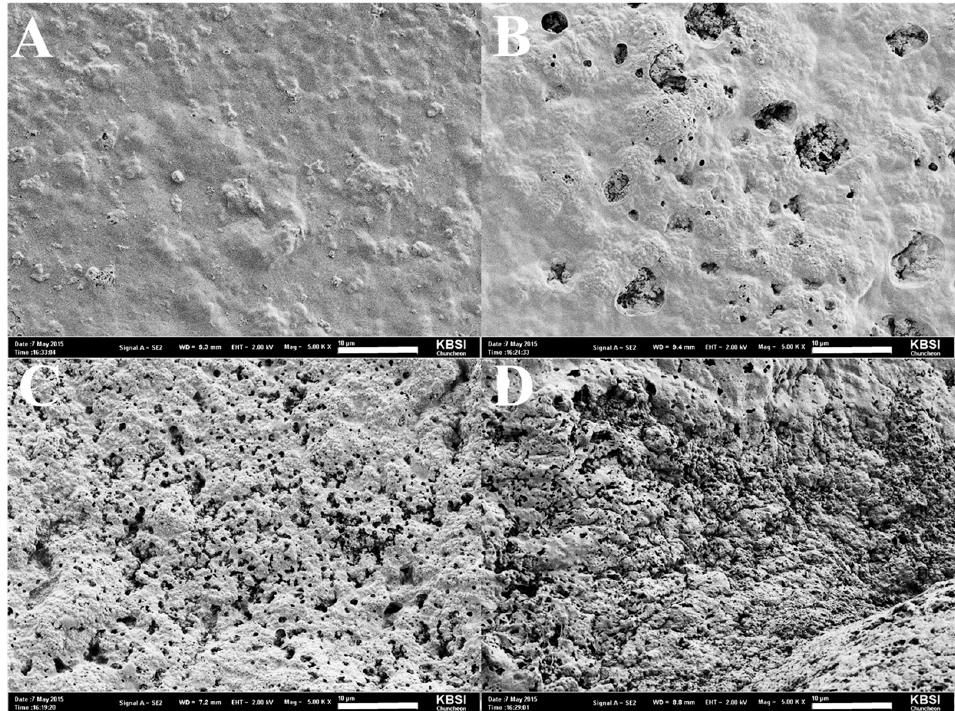
Figure 8. Scanning electron micrographs of the edge part of PSW pork patties (5000× magnification): ( A ) before microwave heating (sous vide), ( B – D ) heated in the tray with center-perforated lid, edge- perforated lid, and without lid, respectively. Scale = 10 μ m.